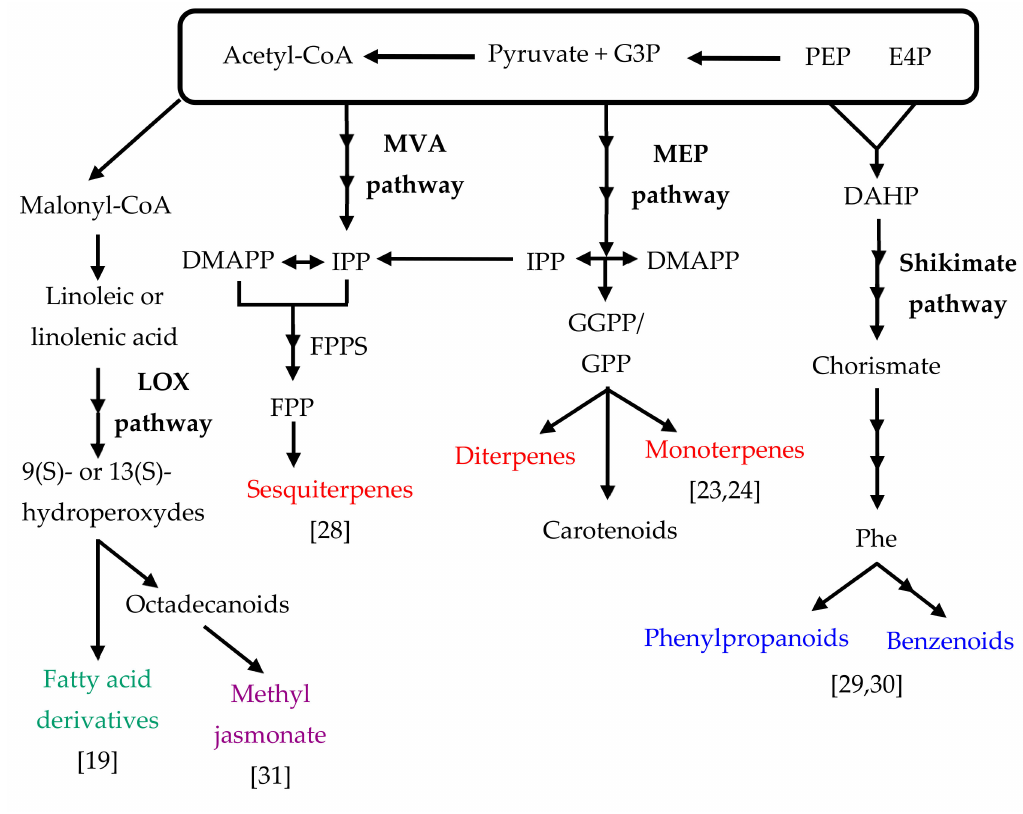
Figure 1. Floral volatile compound responsible pathways in orchid flowers. Major orchid floral volatile compounds are highlighted in colors (sesquiterpenes [28], monoterpenes